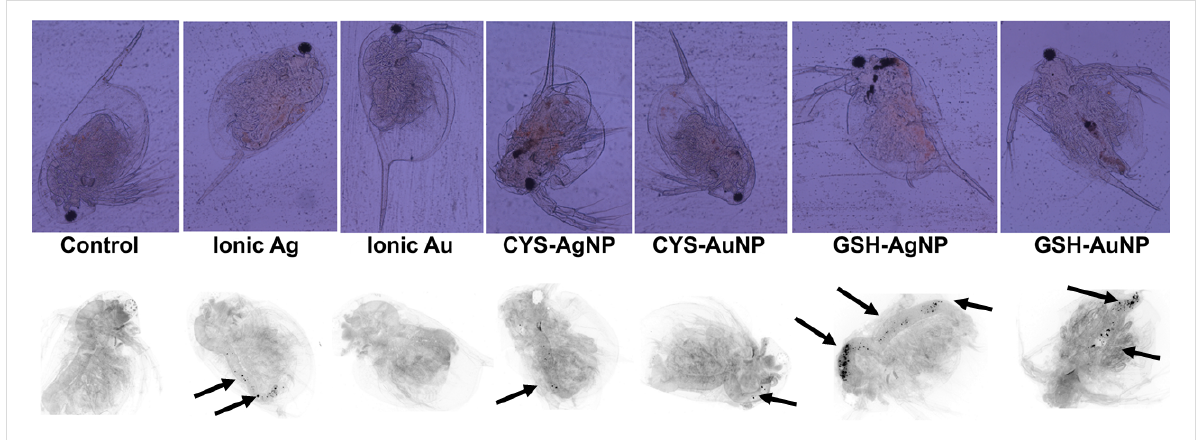
Figure 7: Micrographs of D. magna neonates after 48 h exposure to ionic and nanoparticulate forms of Ag and Au. Visible accumulation is marked with